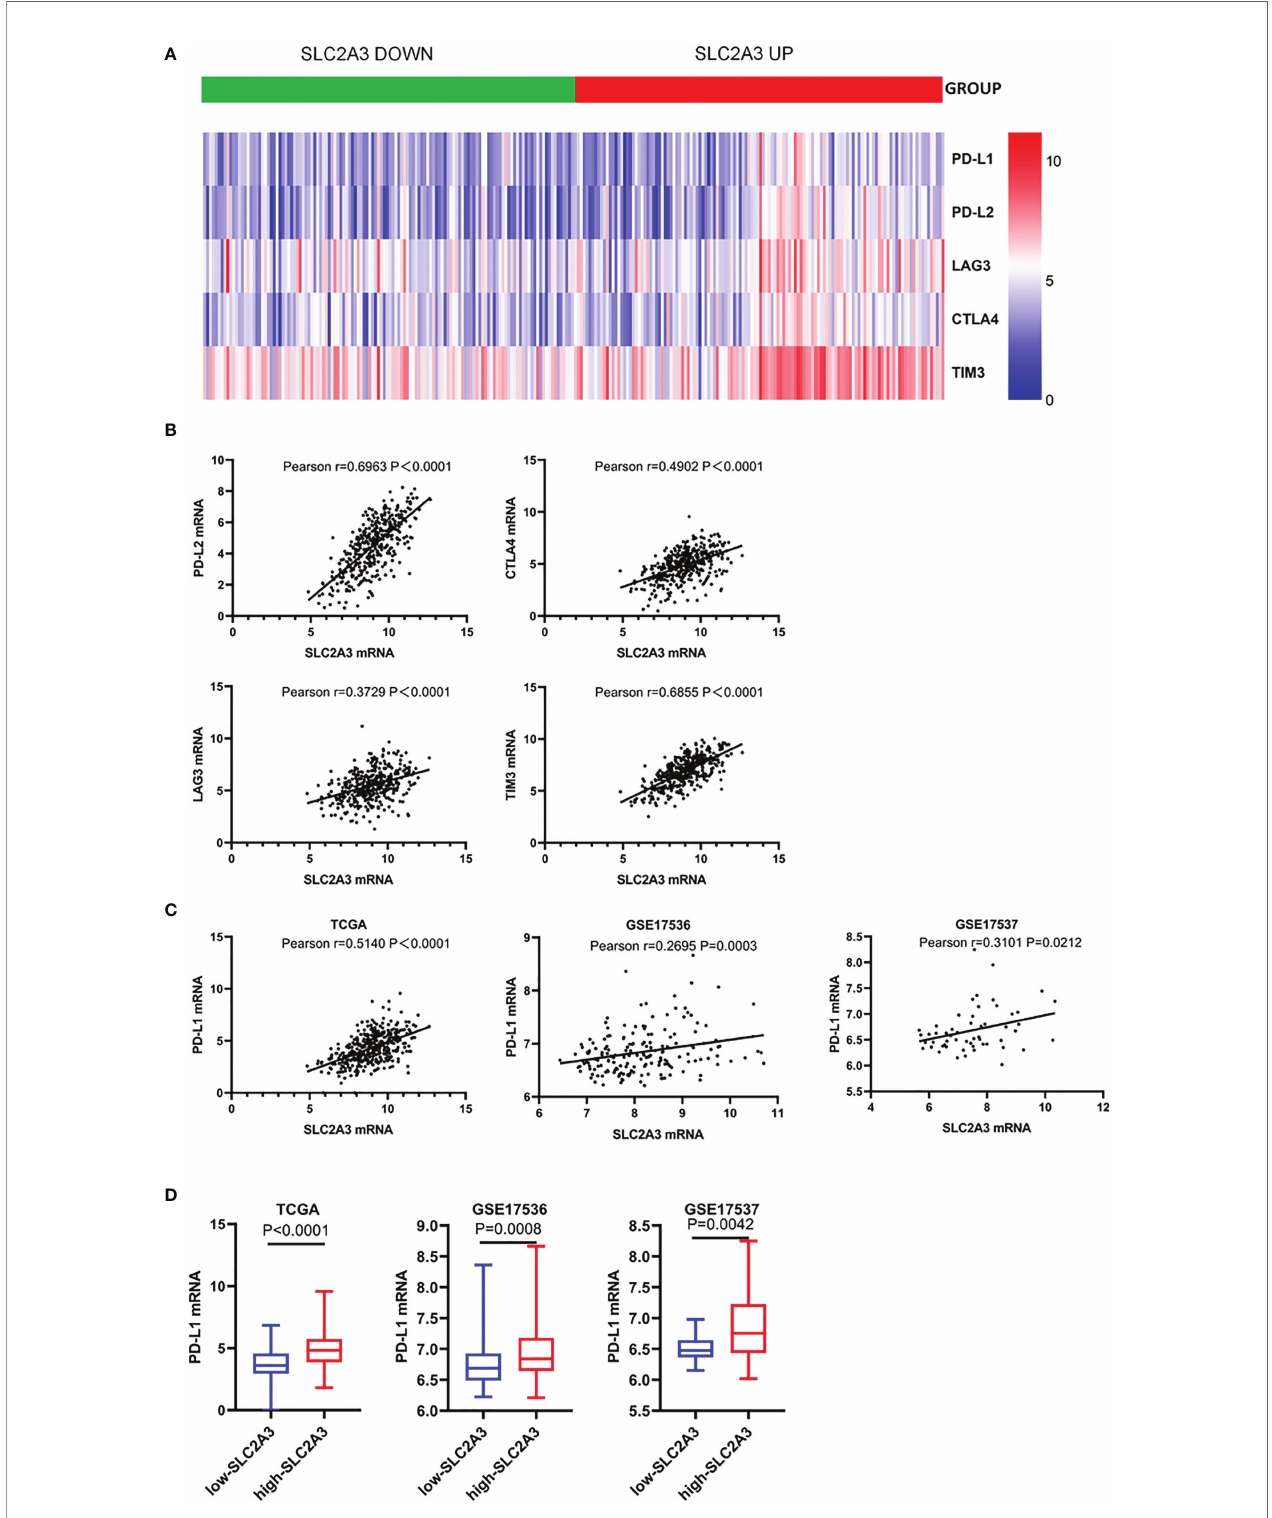
FIGURE 5 | SLC2A3 expression was signi fi cantly associated with PD-L1 expression. (A) heatmap of immune checkpoints based on SLC2A3 expression; (B) the correlation between SLC2A3 expression and immune checkpoints; (C) the correlation between SLC2A3 expression and PD-L1 expression in different database; (D) PD-L1 mRNA expression increased by SLC2A3